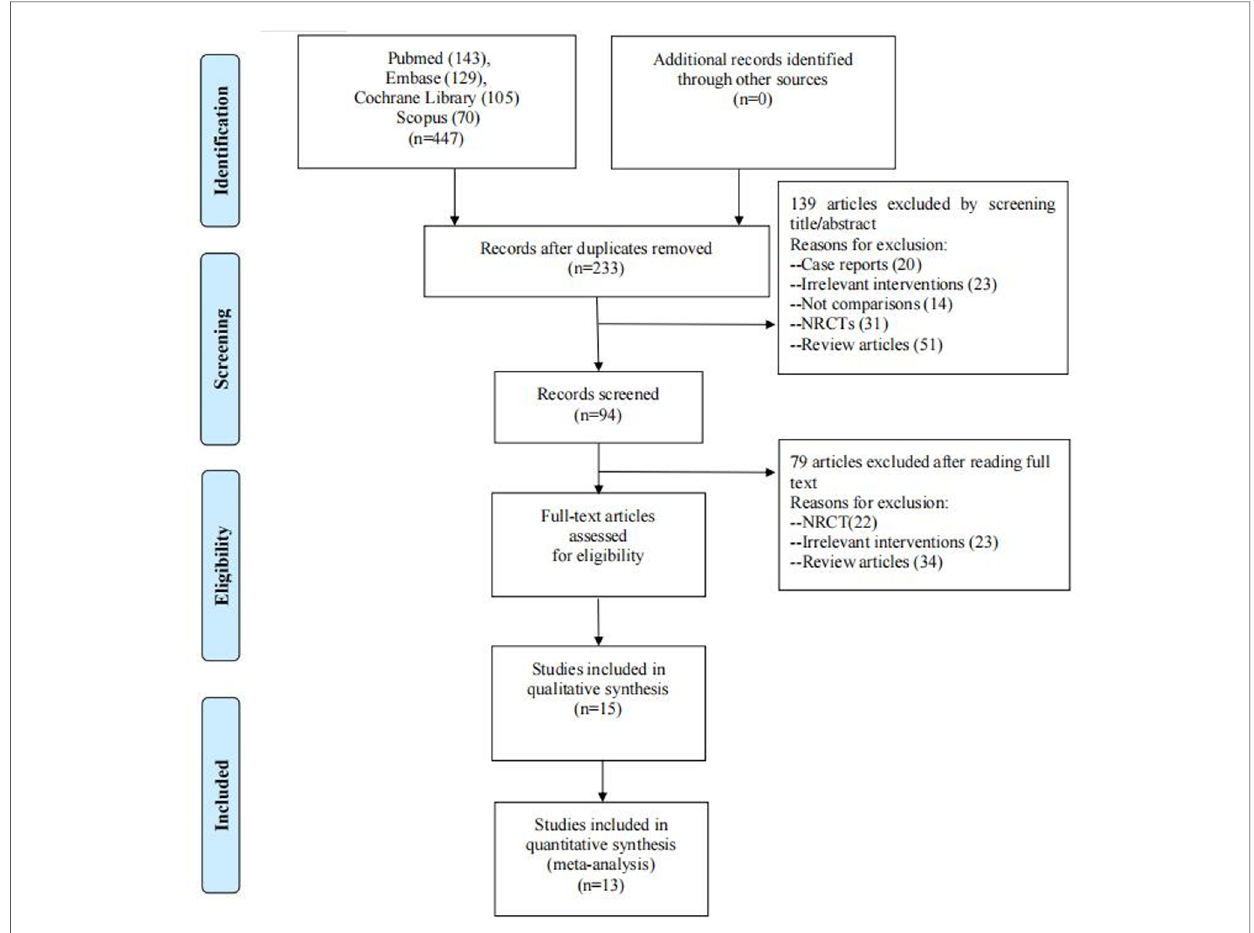
FIGURE 1 Selection fl owchart of included studies.